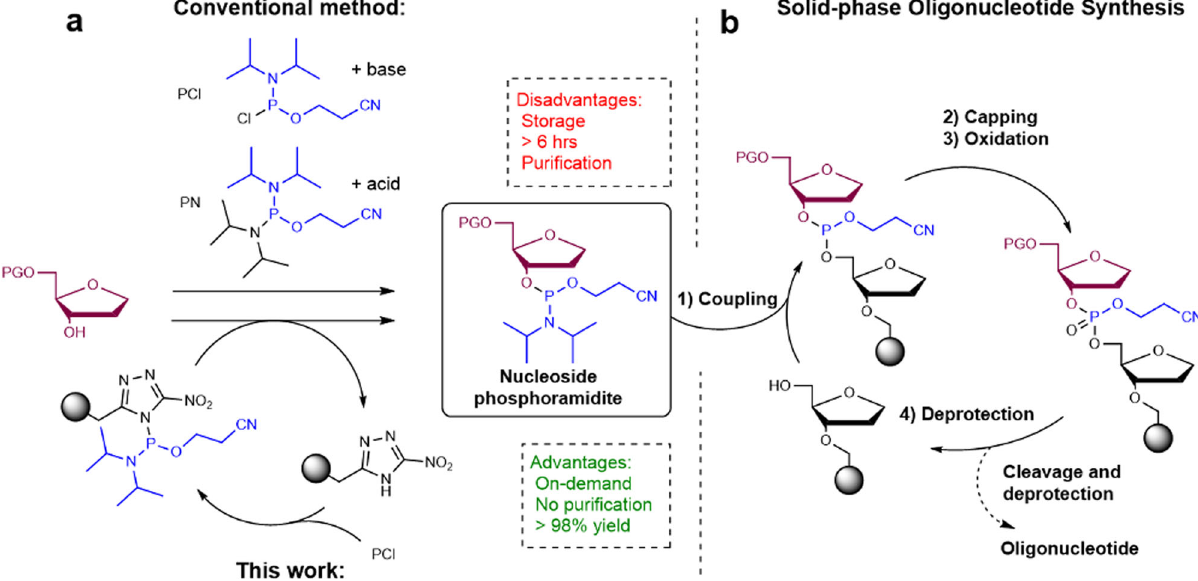
Fig. 1 Strategy for phosphoramidite synthesis in a fl ow-based setup. a Binding of P(III)-species to the resin followed by transfer to a desired alcohol followed by, b direct submission to solid-phase oligonucleotide synthesis. PG protecting